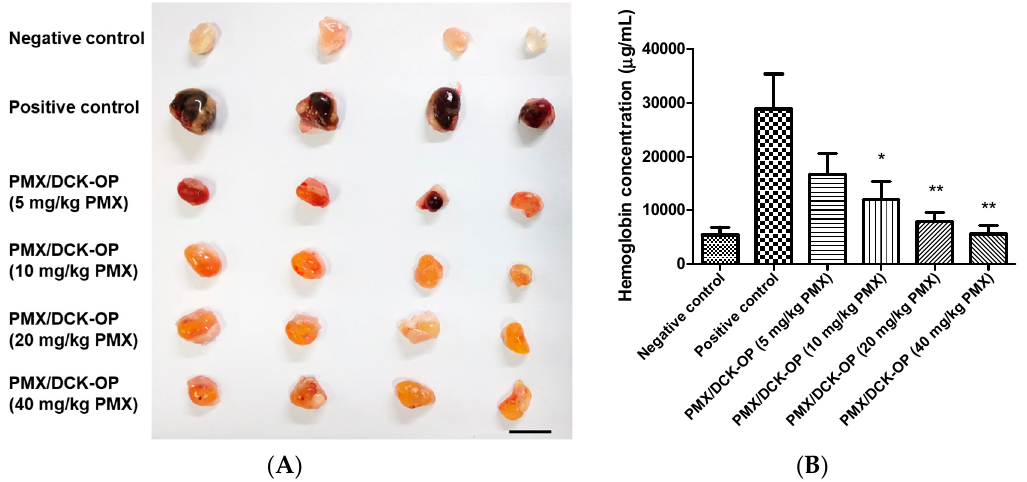
Figure 5. In vivo anti-angiogenic effect of PMX/DCK-OP. Angiogenesis was induced in a subcutaneously implanted Matrigel plug by vascular endothelial growth factor 165 (VEGF 165 ) and basic fibroblast growth factor (bFGF) in C57BL/6 mice. The negative control did not contain any growth factors. The negative and positive groups received saline while treatment groups received 5 mg/kg, 10 mg/kg, 20 mg/kg or 40 mg/kg of PMX/DCK-OP based on PMX everyday by the oral route. ( A ) Representative images of extracted Matrigel plugs from C57BL/6 mice at day 7. ( B ) Quantification of hemoglobin content from Matrigel plugs ( n = 5). Bar means 10 mm. Data are expressed as mean ± SEM. * p < 0.05, ** p < 0.01 compared to the positive control.